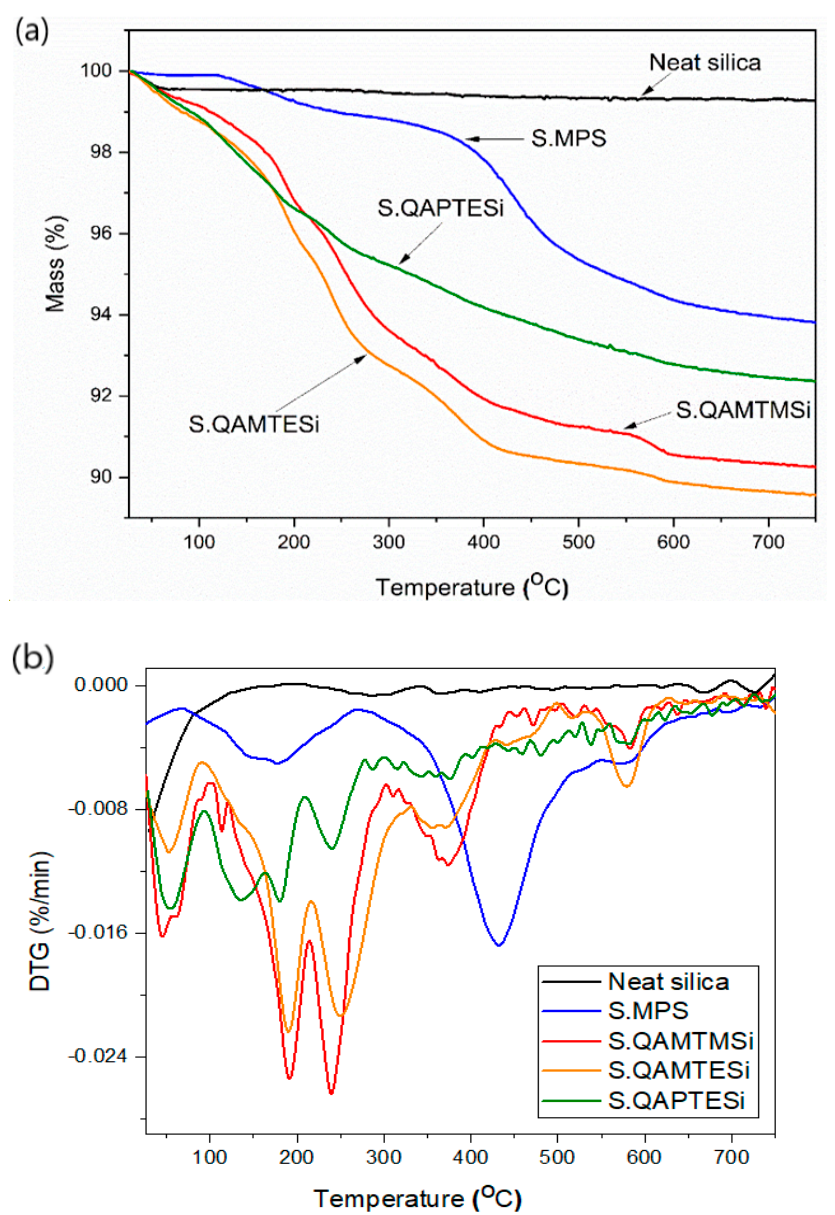
Figure 4. ( a ) TG comparative scans reflecting the different thermal stability of the tested silica nanoparticles; ( b ) DTG curves for neat silica, S.MPS, S.QAMTMSi, S.QAMTESi, S.QAPTESi. Table 2. Percentage (wt%) of each silane attached on the silica surface determined by TGA method.